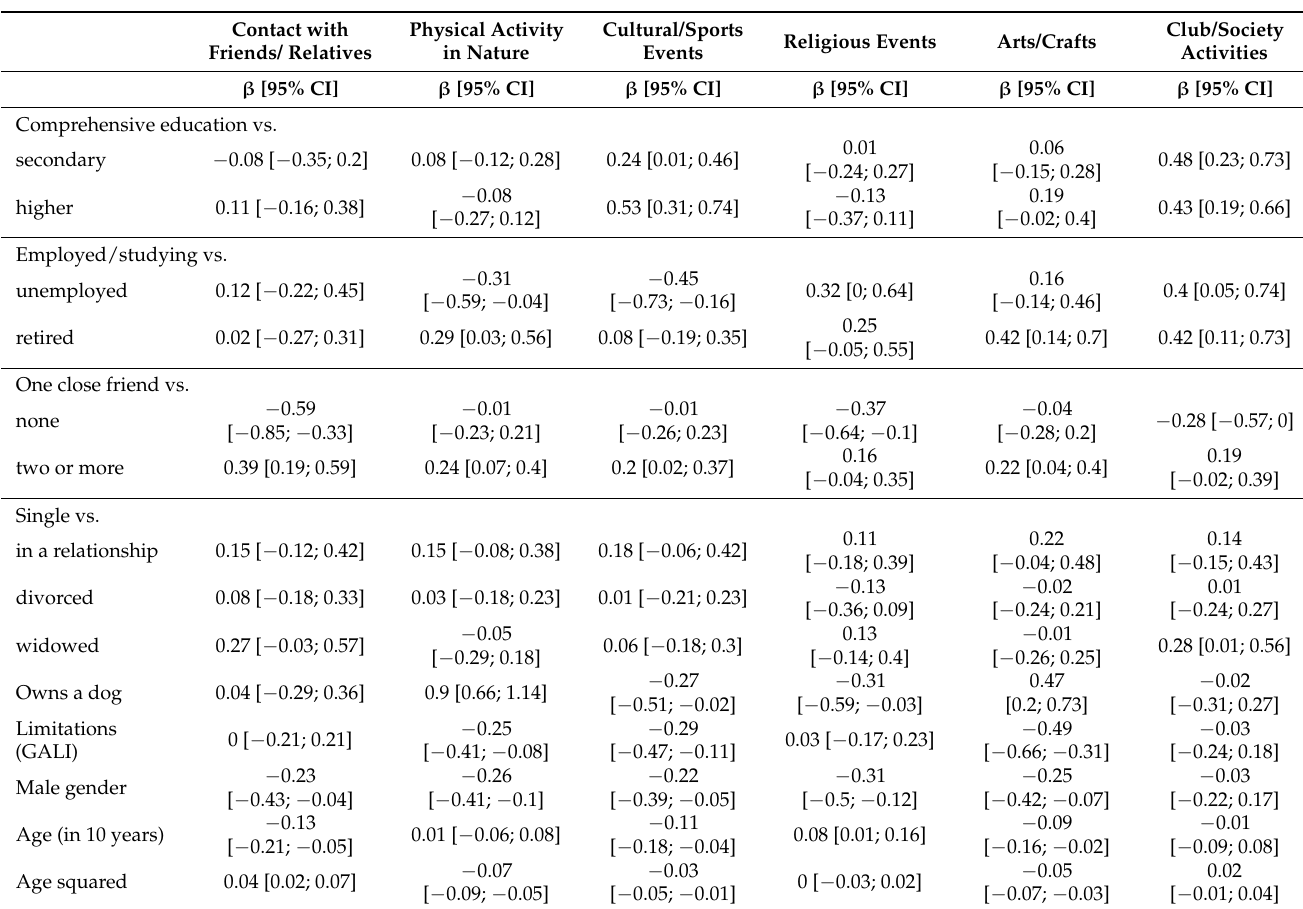
Table 3. Standardised coefficients and their 95% CIs from circumstantial factors to leisure activities in the main model ( n = 801). Contact with Friends/ Relatives Comprehensive education